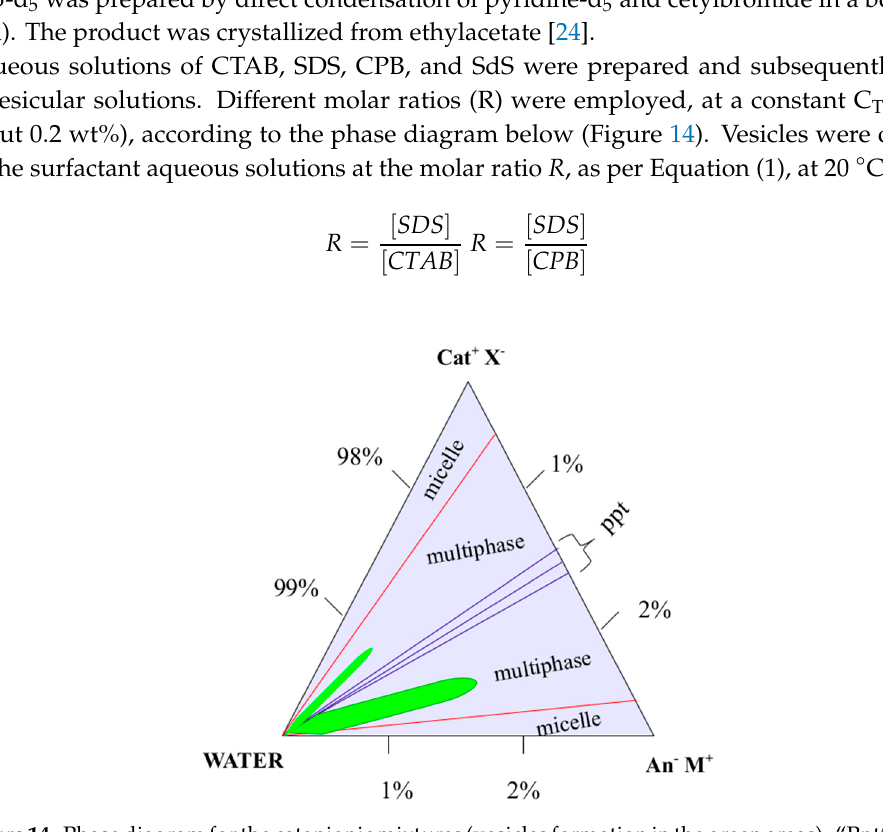
Figure 14. Phase diagram for the catanionic mixtures (vesicles formation in the green areas). “Ppt” stands for precipitation areas, “An” refers to the anionic partner, whereas “Cat” is the cationic component.